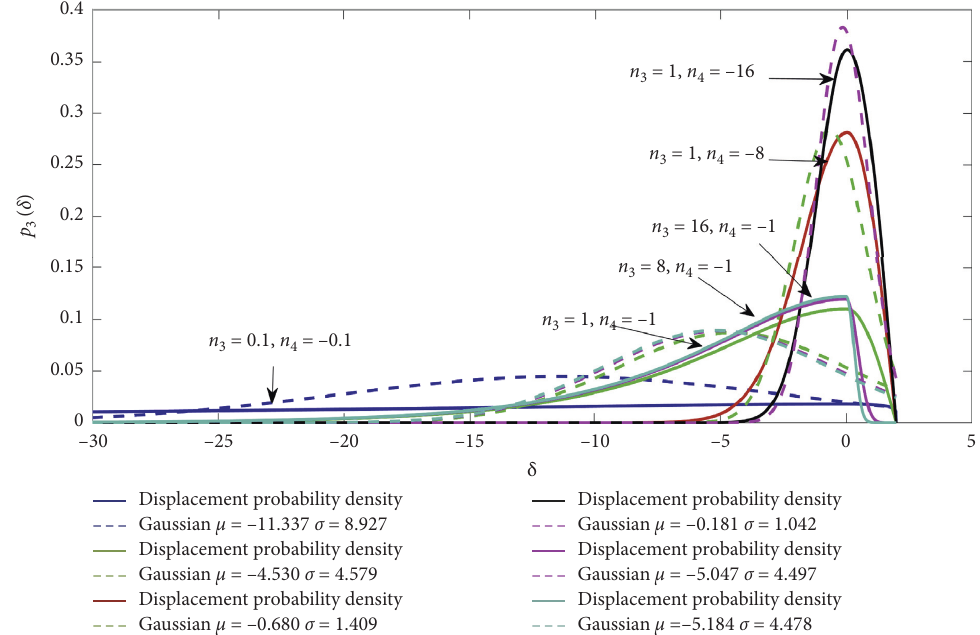
Figure 17: Displacement PDFs of ATHNPS for various values of n